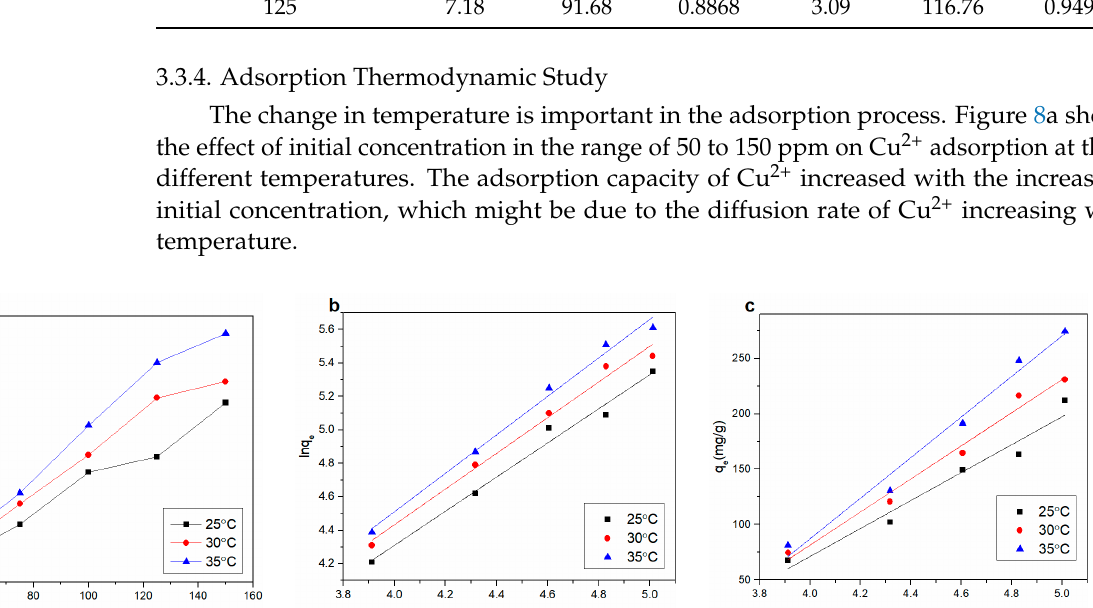
isotherms for adsorption of Cu 2+ .